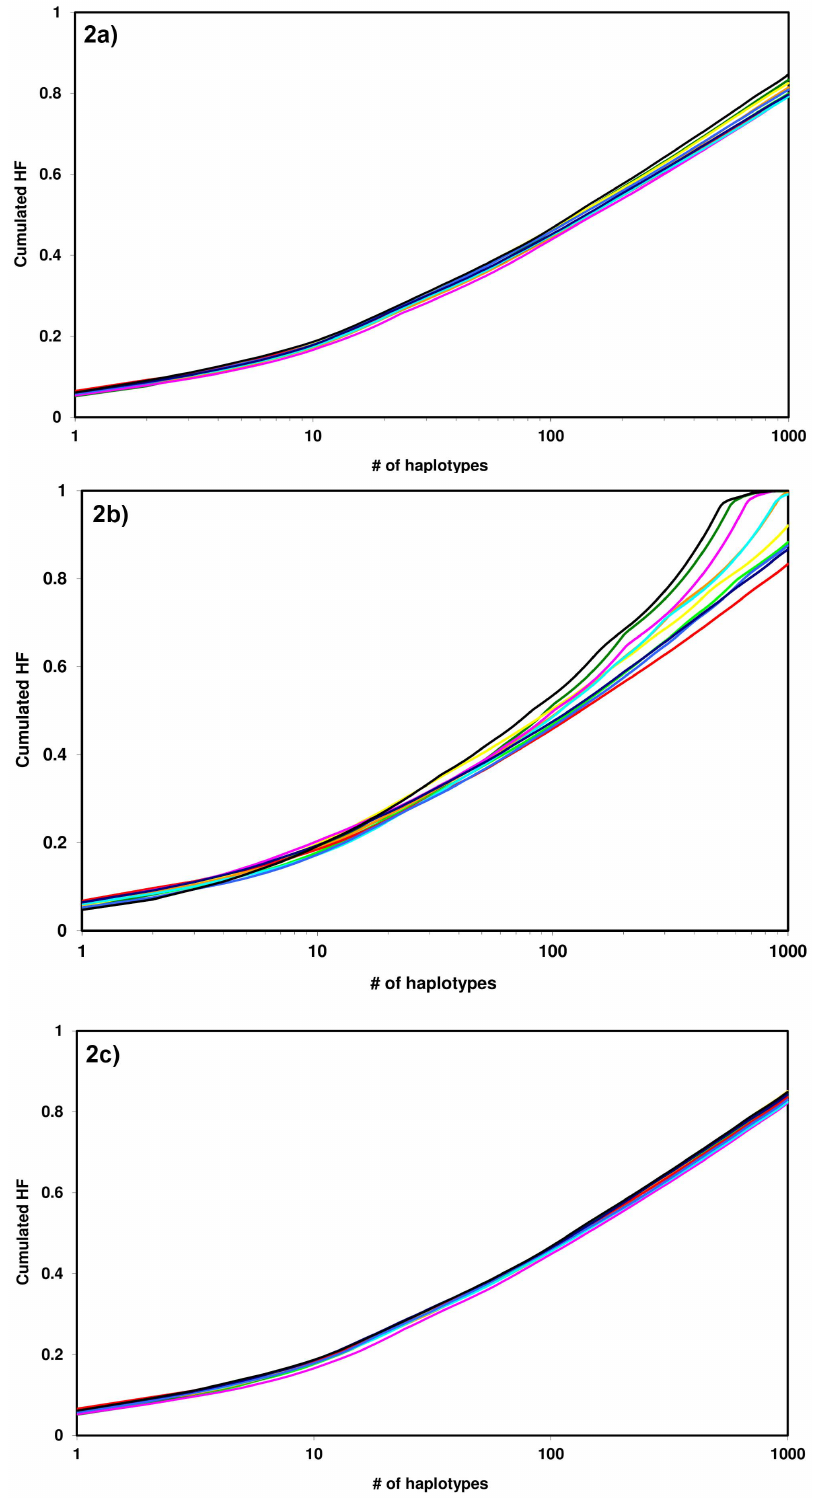
Figure 2. Cumulated HF by Polish 1-digit postal code regions. Light green, region 0; dark green, 1; yellow, 2; orange, 3; red, 4; violet, 5; turquoise, 6; light blue, 7; dark blue, 8; black, 9. HF were estimated from the regional sub-files of the data set including n =123,749 donors (see Table 1 for sub-file sizes, Figure 2a), from the regional sub-files of the data set including n =20,653 donors ([12], Figure 2b), and from regional random samples (see Methods section, Figure 2c). For regions 4, 6 and 9, the points of the cumulated HF curves were calculated as mean values of the respective samples A–C.